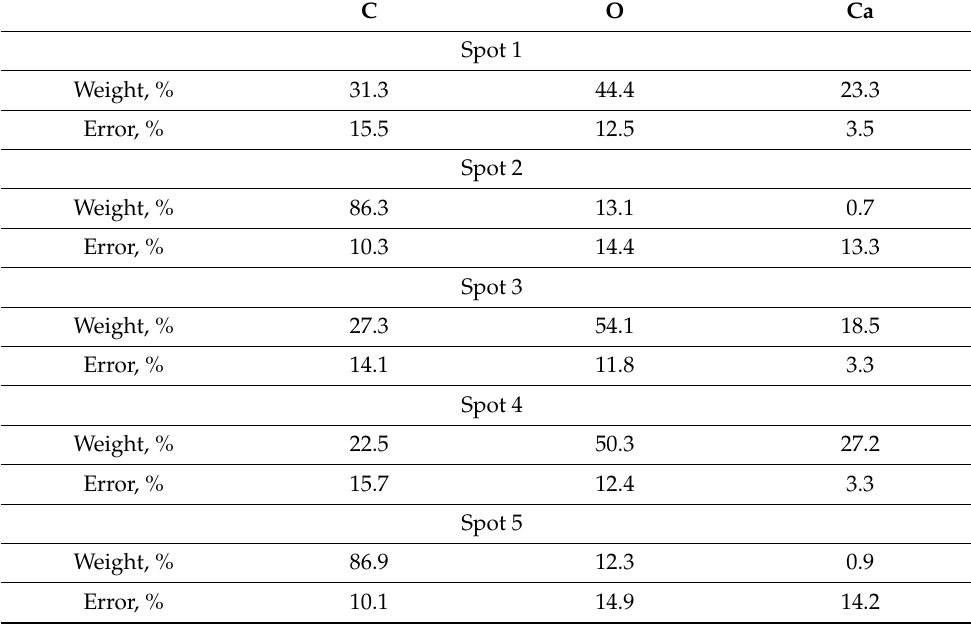
Table 3. Results of EDS analysis of sample B.